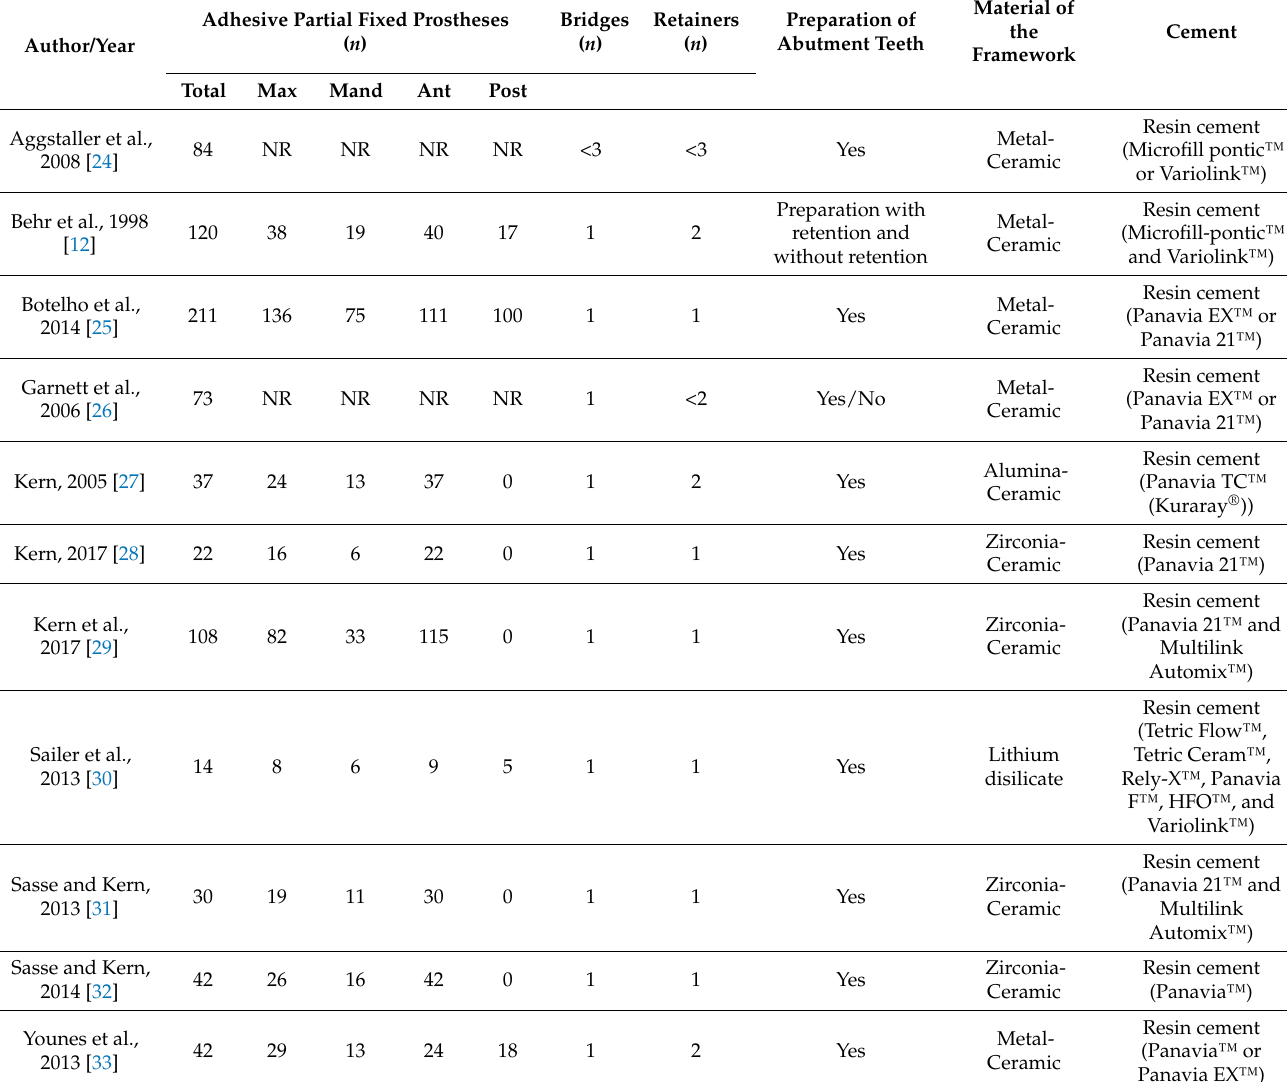
Table 1. Data extraction table and descriptive analysis of the included articles.